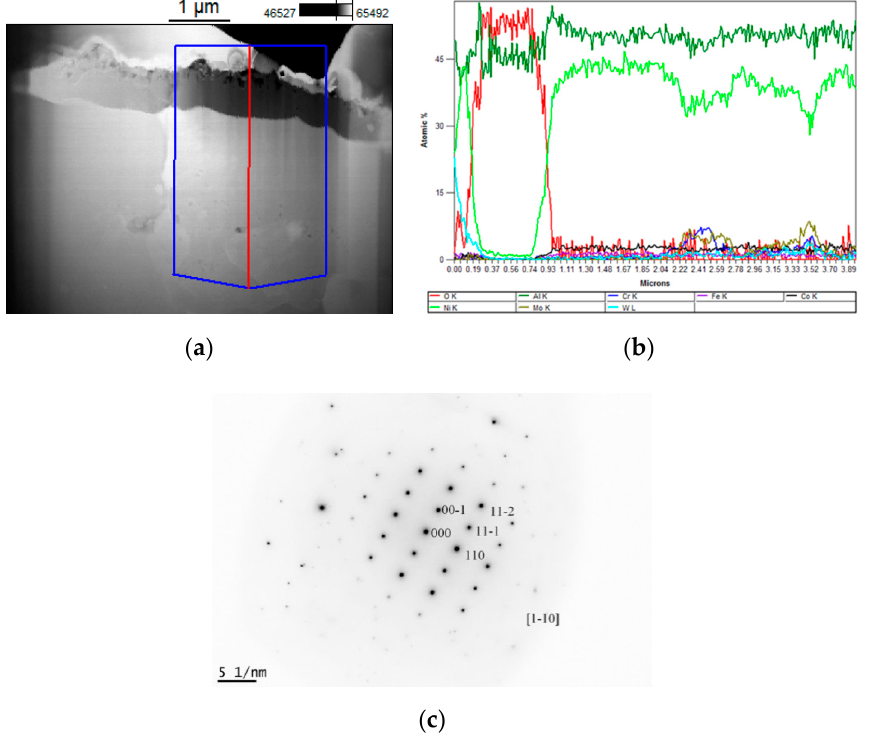
Figure 2. Microstructures, linear scans of the chemical composition, and phase identification representative of layers on the nickel superalloy: ( a ) STEM image of a cross-section; ( b ) linear scans of alloying elements; ( c ) Selected Area Diffraction (SAD) pattern of the NiAl disordered alloy .